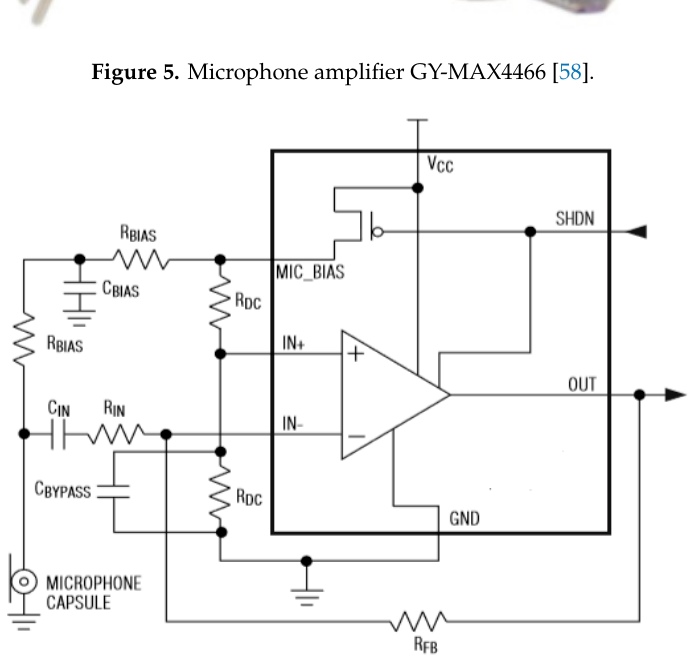
Figure 6. Electric schematic of GY-MAX4466 [58].